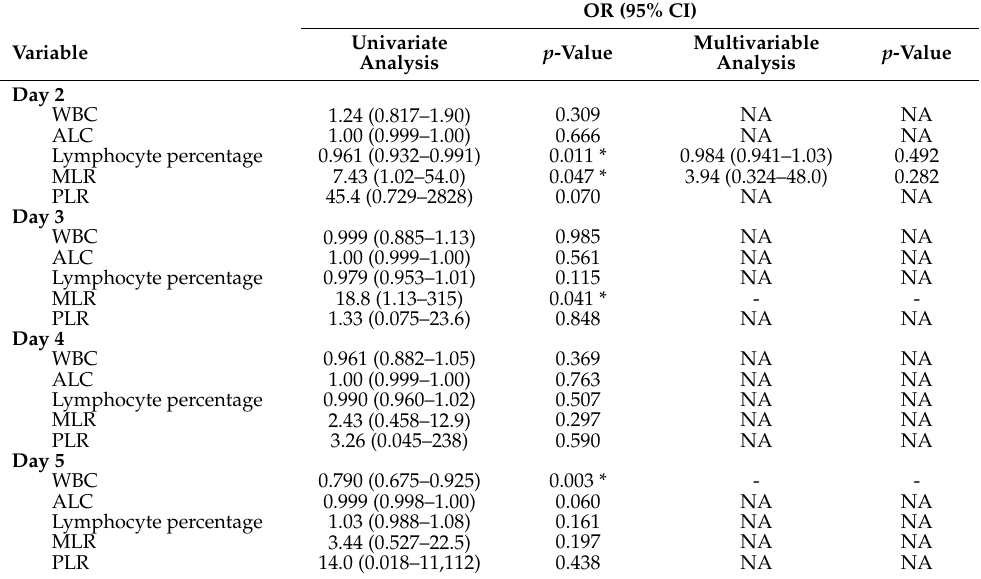
Table 5. Univariate and multivariate analysis of different measures and ratios in predicting the absolute neutrophil count difference